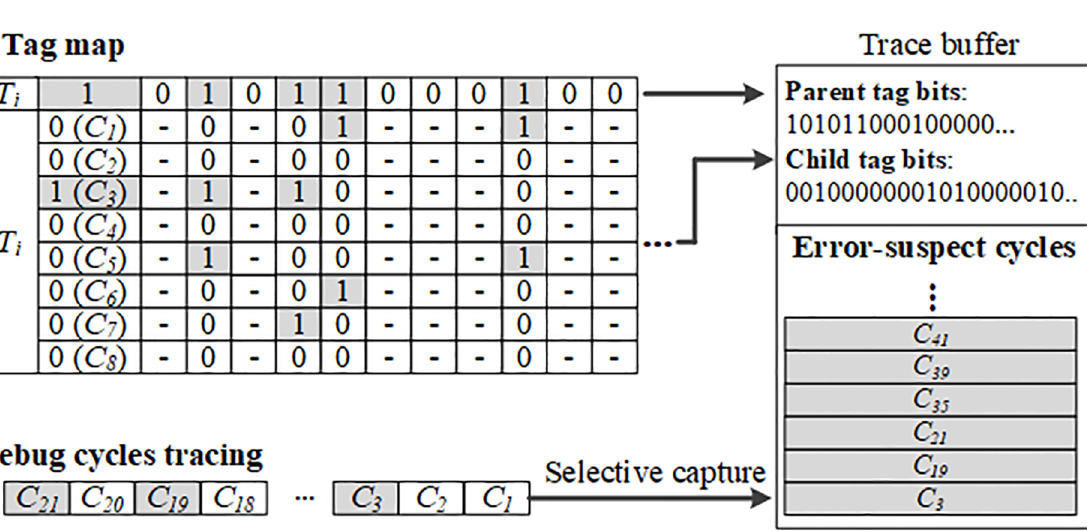
Fig 6. Usage of tag map and capturing of error-suspect debug cycles.